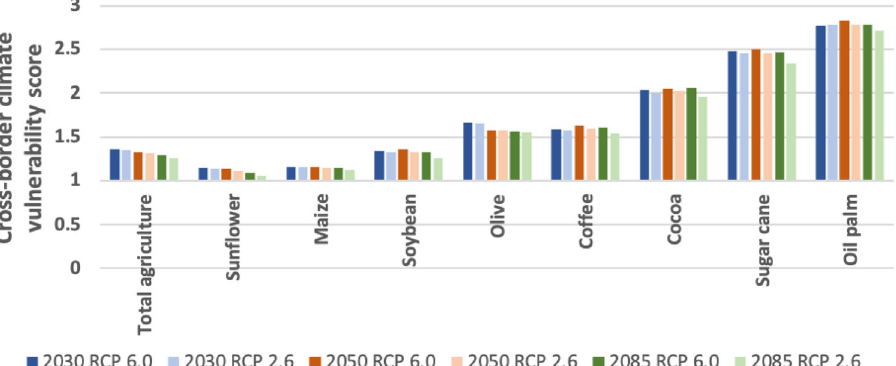
Fig. 4 Cross-border climate vulnerability scores of the EU related to the eight most important crops imported to the EU that explain the continent ’ s external rainfall dependency. The colors of the bars indicate the different year and RCP combinations, 2030 RCP6.0, 2030 RCP2.6, 2050 RCP6.0, 2050 RCP2.6, 2085 RCP6.0,